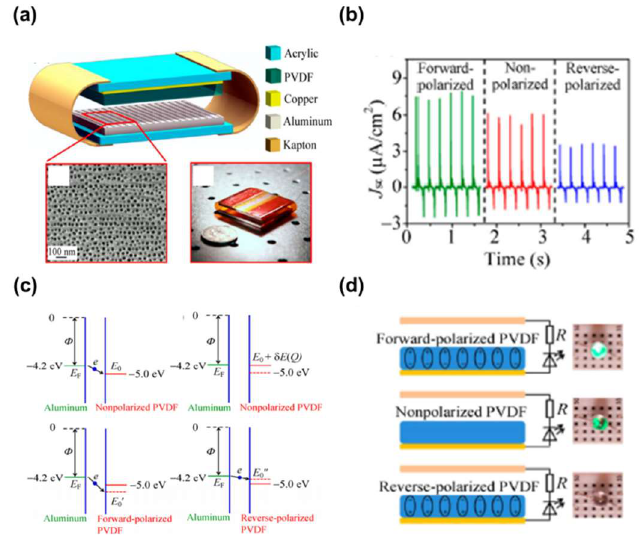
Figure 3. ( a ) The schematic of the TENG with a double-layer structure. A SEM image of nanopores